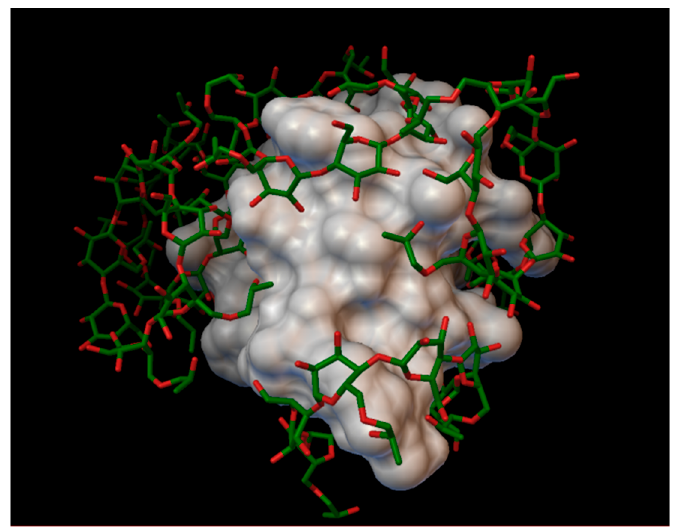
Figure 11. Insulin-hydroxypropyl- β -cyclodextrin (DS 4) complex. The insulin molecular surface is marked with white and the cyclodextrin molecules are marked with with green and red licorice.